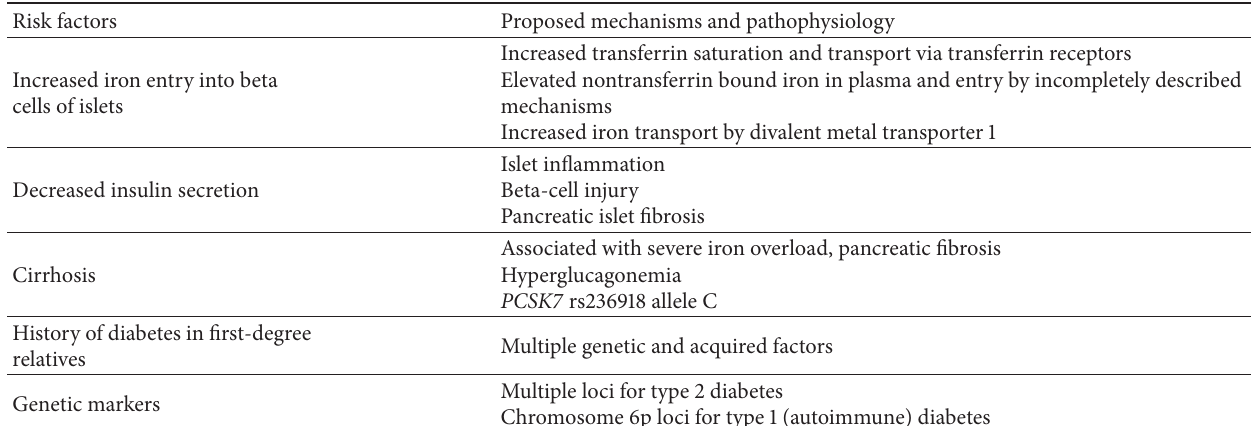
Table 3: Diabetes risk in HFE